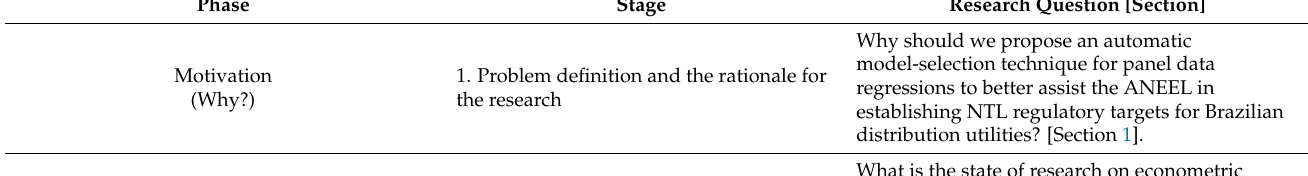
Table 1. Research